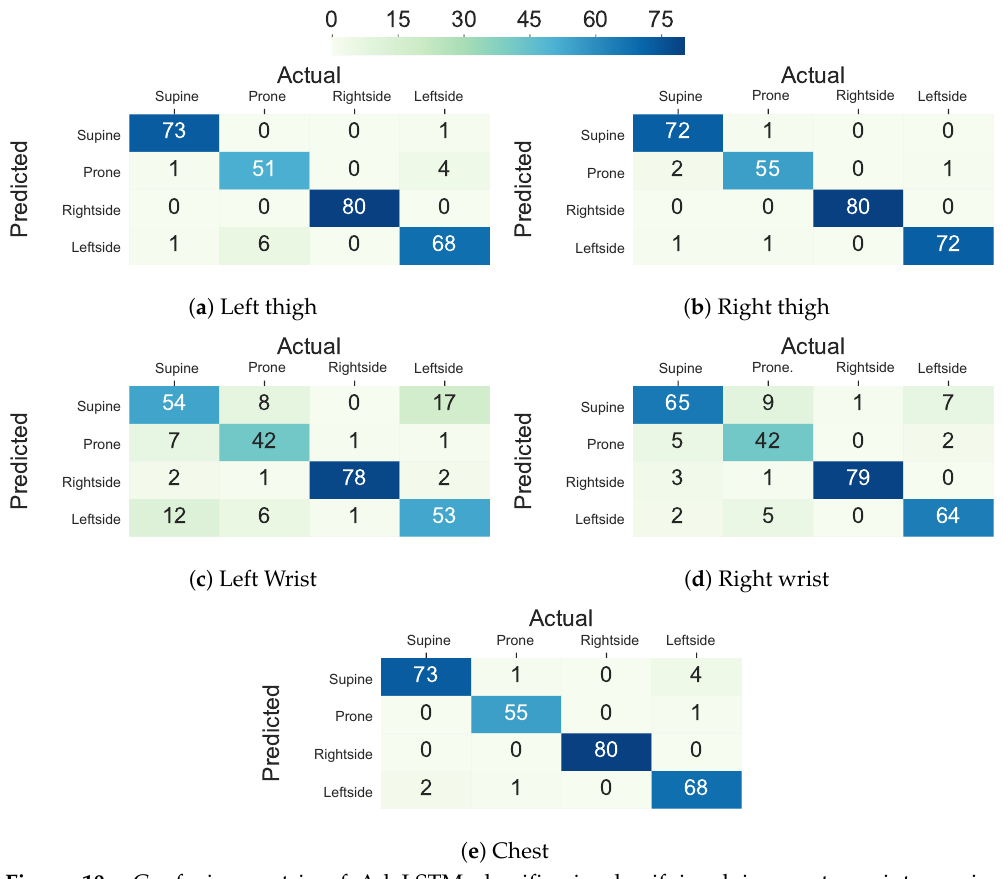
Figure 10. Confusion matrix of AdaLSTM classifier in classifying lying postures into supine, prone, and left side for the thighs, ankles, arms, and wrists